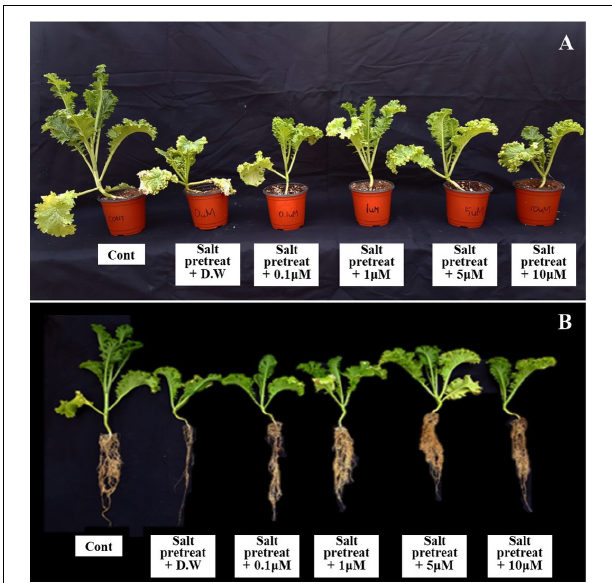
FIGURE 1 | Effect of various melatonin concentrations on the growth of salt-stressed green mustard seedlings (A,B) . Treatment: control + water, 150 mM salt pre-treatment + water, 150 mM salt pre-treatment + 0.1 µ M melatonin, 150 mM salt pre-treatment + 1 µ M melatonin, 150 mM salt pre-treatment + 5 µ M melatonin, 150 mM salt pre-treatment + 10 µ M melatonin.